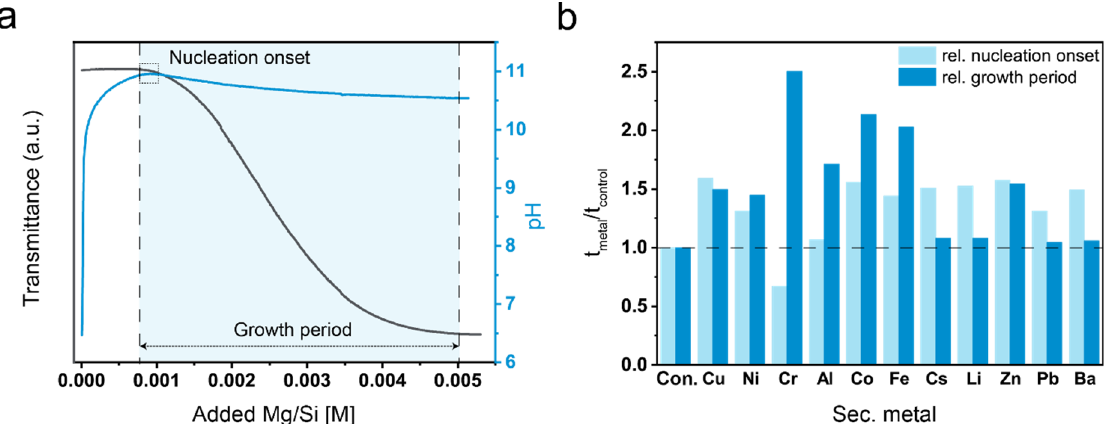
Figure 1. ( a ) Curve for transmission measurement (dark gray) and pH for a control experiment with marked nucleation onset (dashed line on the left) and the end of the so-called growth period (dashed line on the right); ( b ) Nucleation onset and growth period relative to reference experiment determined by transmittance measurements in presence of additive ions.